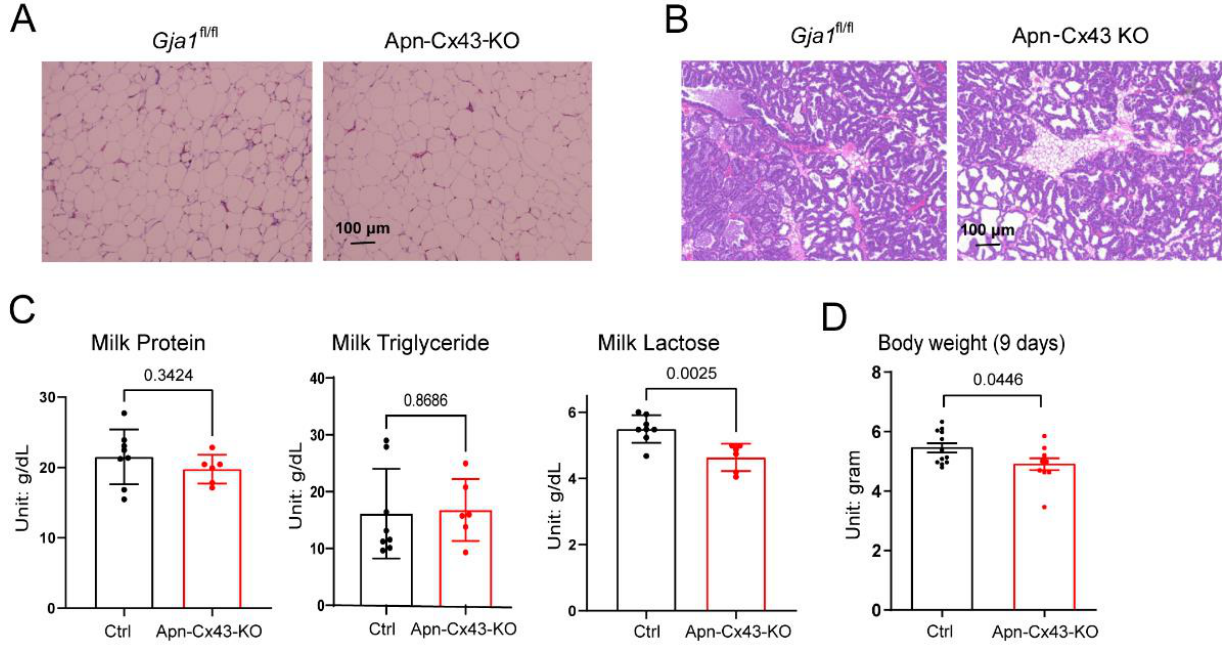
Figure 4. Adipocyte-specific Cx43 deletion reduces breastmilk lactose levels and impairs neonate growth. ( A ) H&E staining of mammary adipose depot from virgin mice. ( B ) H&E staining of mam- mary adipose depot from mice that have been lactating for 9 days. ( C ) Breastmilk macronutrient concentration ( n = 8 for control (Ctrl) group, n = 6 for Apn-Cx43-KO group). ( D ) Average body weight of cross-fostered pups by control (Ctrl) or Apn-Cx43-KO dams (the average body weight of pups from one dam is regarded as one sample. n = 12 for Ctrl group, n = 10 for Apn-Cx43-KO group). All data are mean ± SEM.